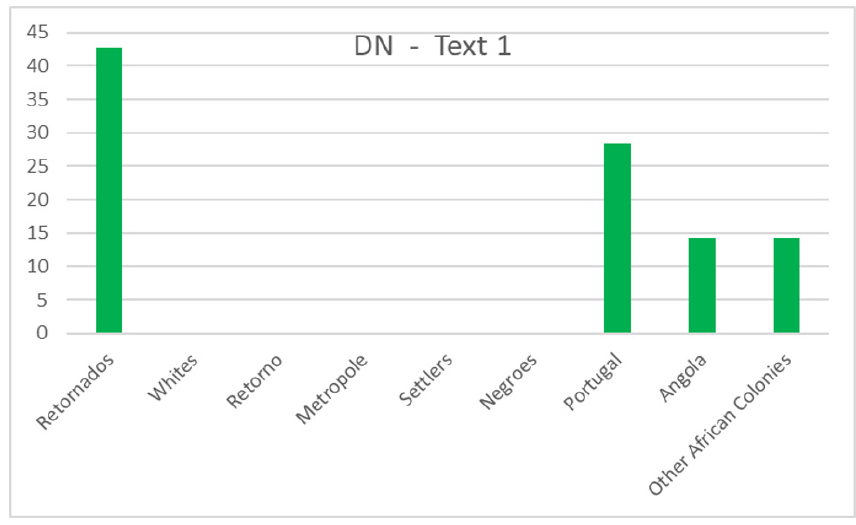
Figure 11. Most frequent words in the text “Retornados de África, a imigração invisível”. Source: Diário de Notícias (2005) [25].